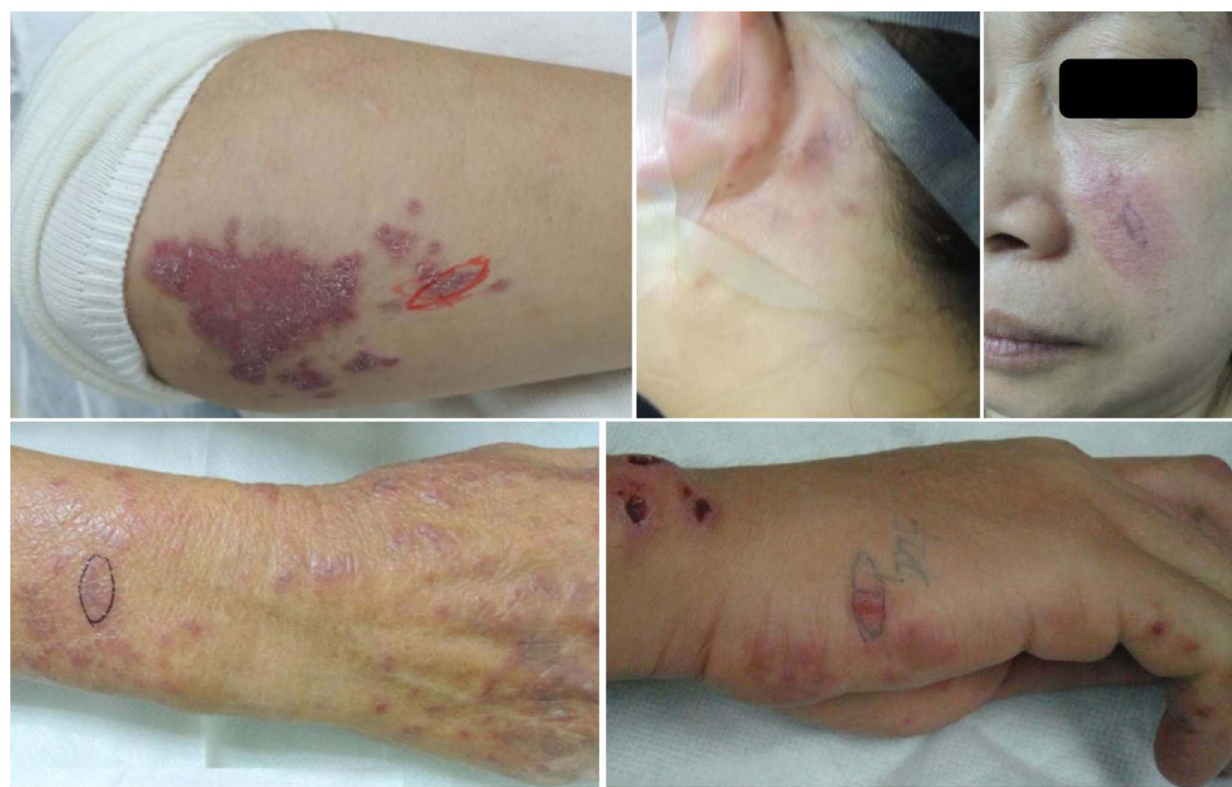
Figure 1. Cutaneous lesions in SLE patients. The skin injury of SLE presents multiple morphologies, including atrophic scaly purplish-red macules, papules and plaques, indurate erythema and vacuities as well.